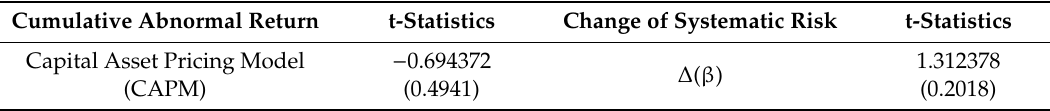
Table 1. Simple hypothesis testing